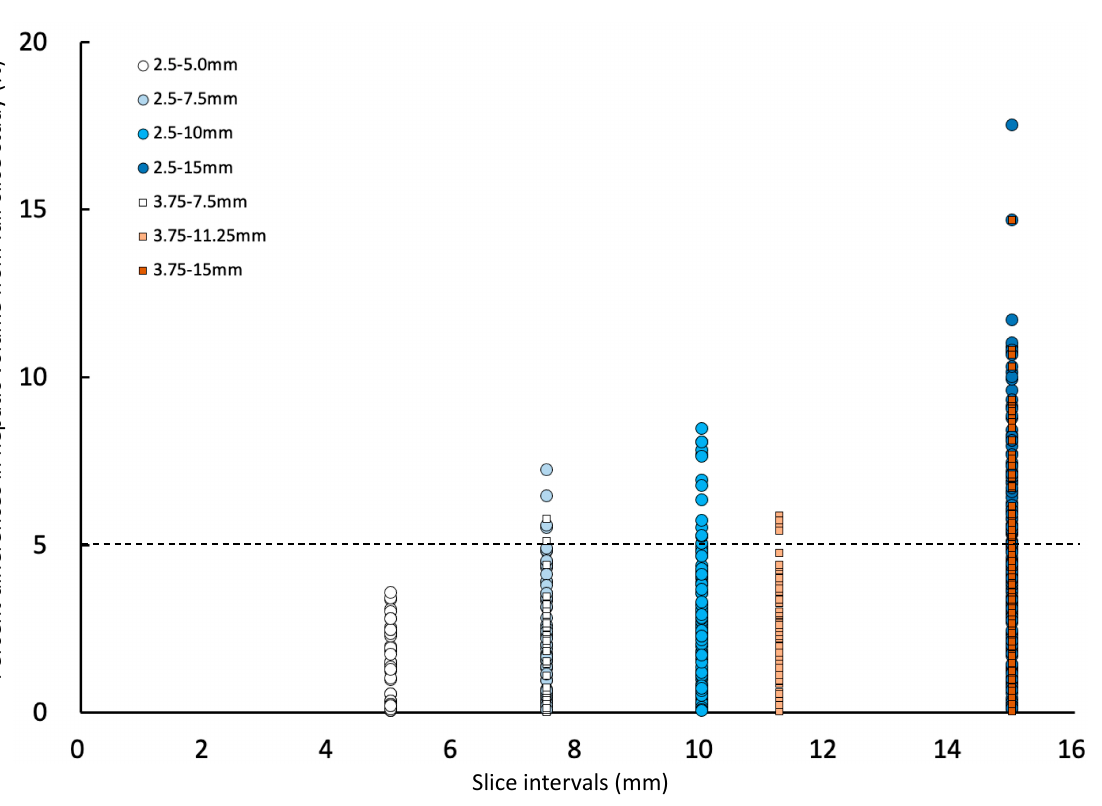
Figure 3. Percent differences in hepatic volume of each interslice gaps compared to 2.5 mm-full or 3.75 mm-full. The percent difference lower than dotted line (less than 5%) is considered acceptable. Percent differences in hepatic volume compared to the corresponding full hepatic volume (2.5-full or 3.75-full group) with numbers of slices used for hepatic volumetry are shown in Figure 4. The greatest percent differences in hepatic volume compared to the corresponding full hepatic volume (2.5-full or 3.75-full group) were 17.5% using less than 10 slices, 9.0% using 10 to 14 slices, 5.5% using 15 to 19 slices, 4.8% using 20 to 24 slices, and 2.6% using more than 25 slices (Figure 4).